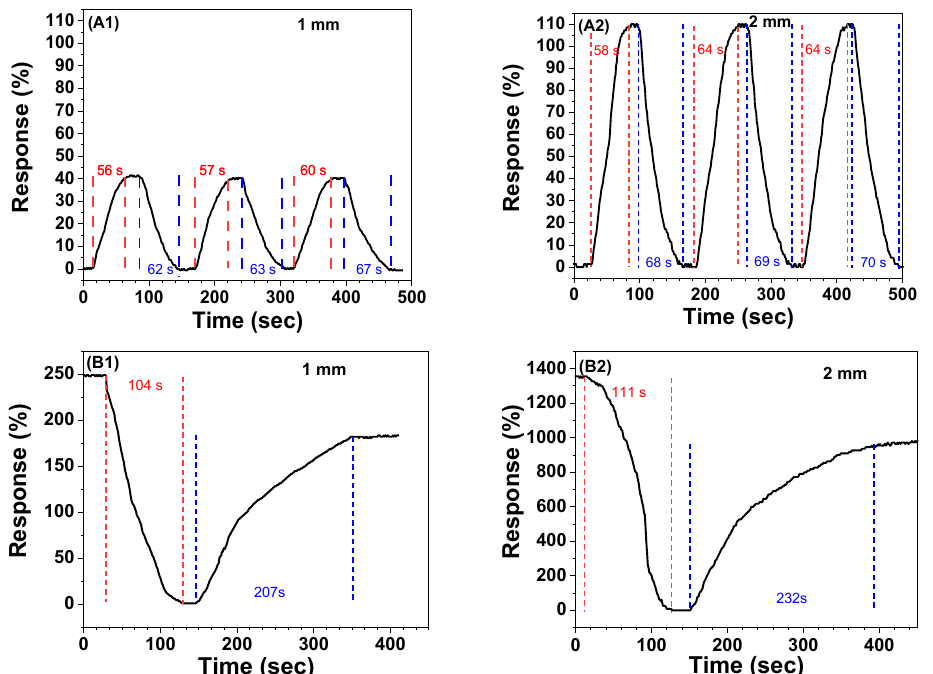
Figure 7. ( A ) Cyclic response of dry 2-2 cryogel with thickness of 1 mm ( A1 ) and 2 mm ( A2 ) to HCl gas. ( B ) Response of dry 2-2 cryogel with thickness of 1 mm ( B1 ) and 2 mm ( B2 ) to NH 3